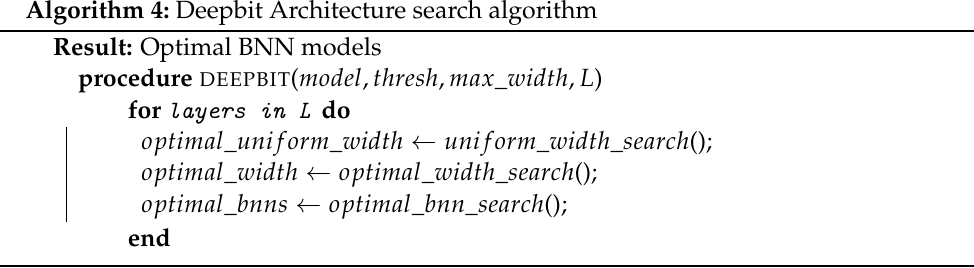
Algorithm 4: Deepbit Architecture search